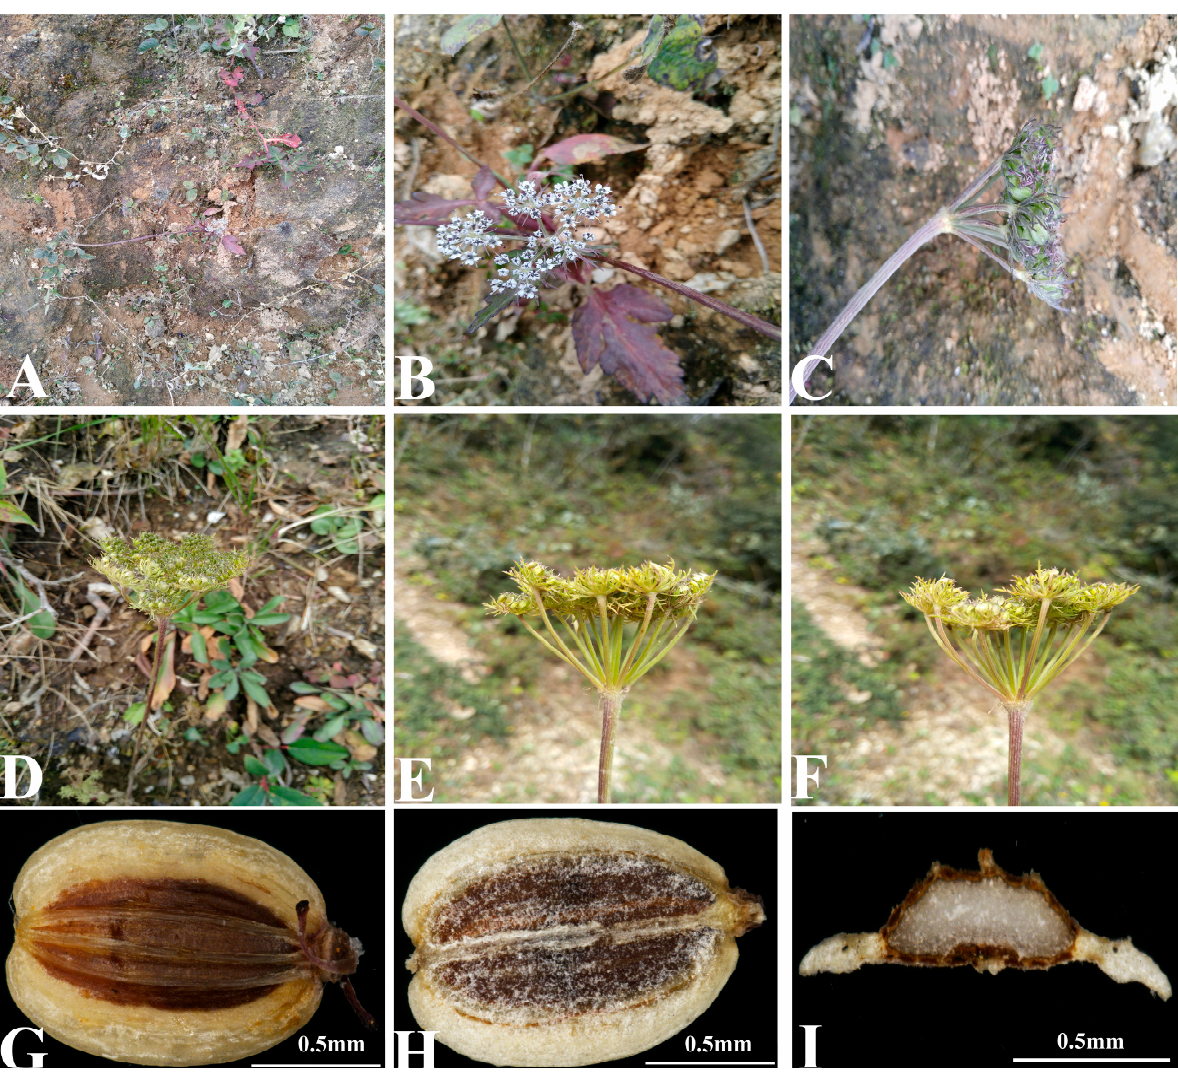
Figure 1. Illustrations of Peucedanum franchetii . ( A ) Habit; ( B ) basal leaves; ( C ) stem leaves; ( D ) umbel with bracts and bracteoles; ( E ) flower; ( F ) young mericarp with calyx teeth; ( G ) dorsal of mericarp; ( H ) commissural of mericarp; ( I ) cross-section of mericarp. Scale bars: 0.5 mm (G, H, I)